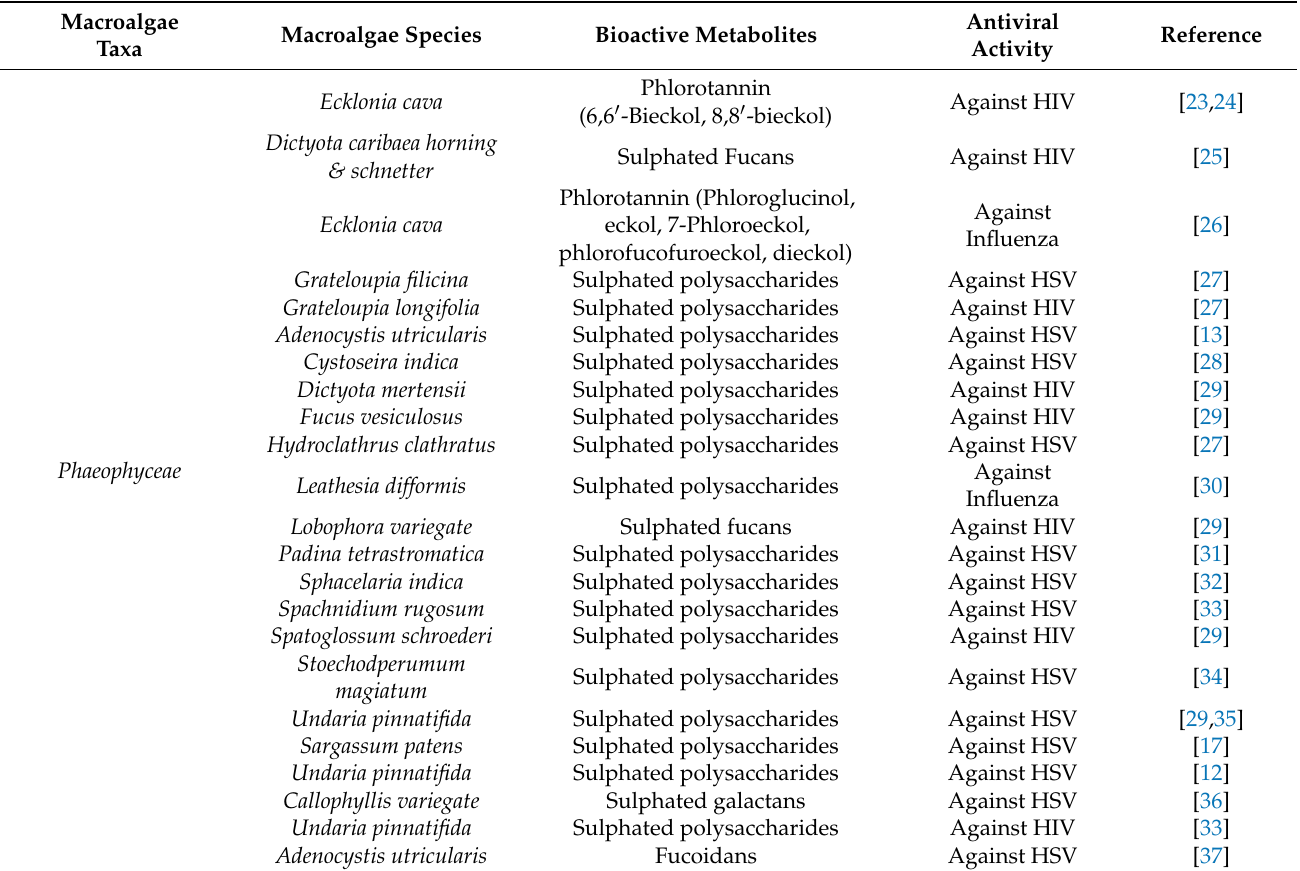
Table 1. A review of antiviral activity of macroalgae— Phaeophycea